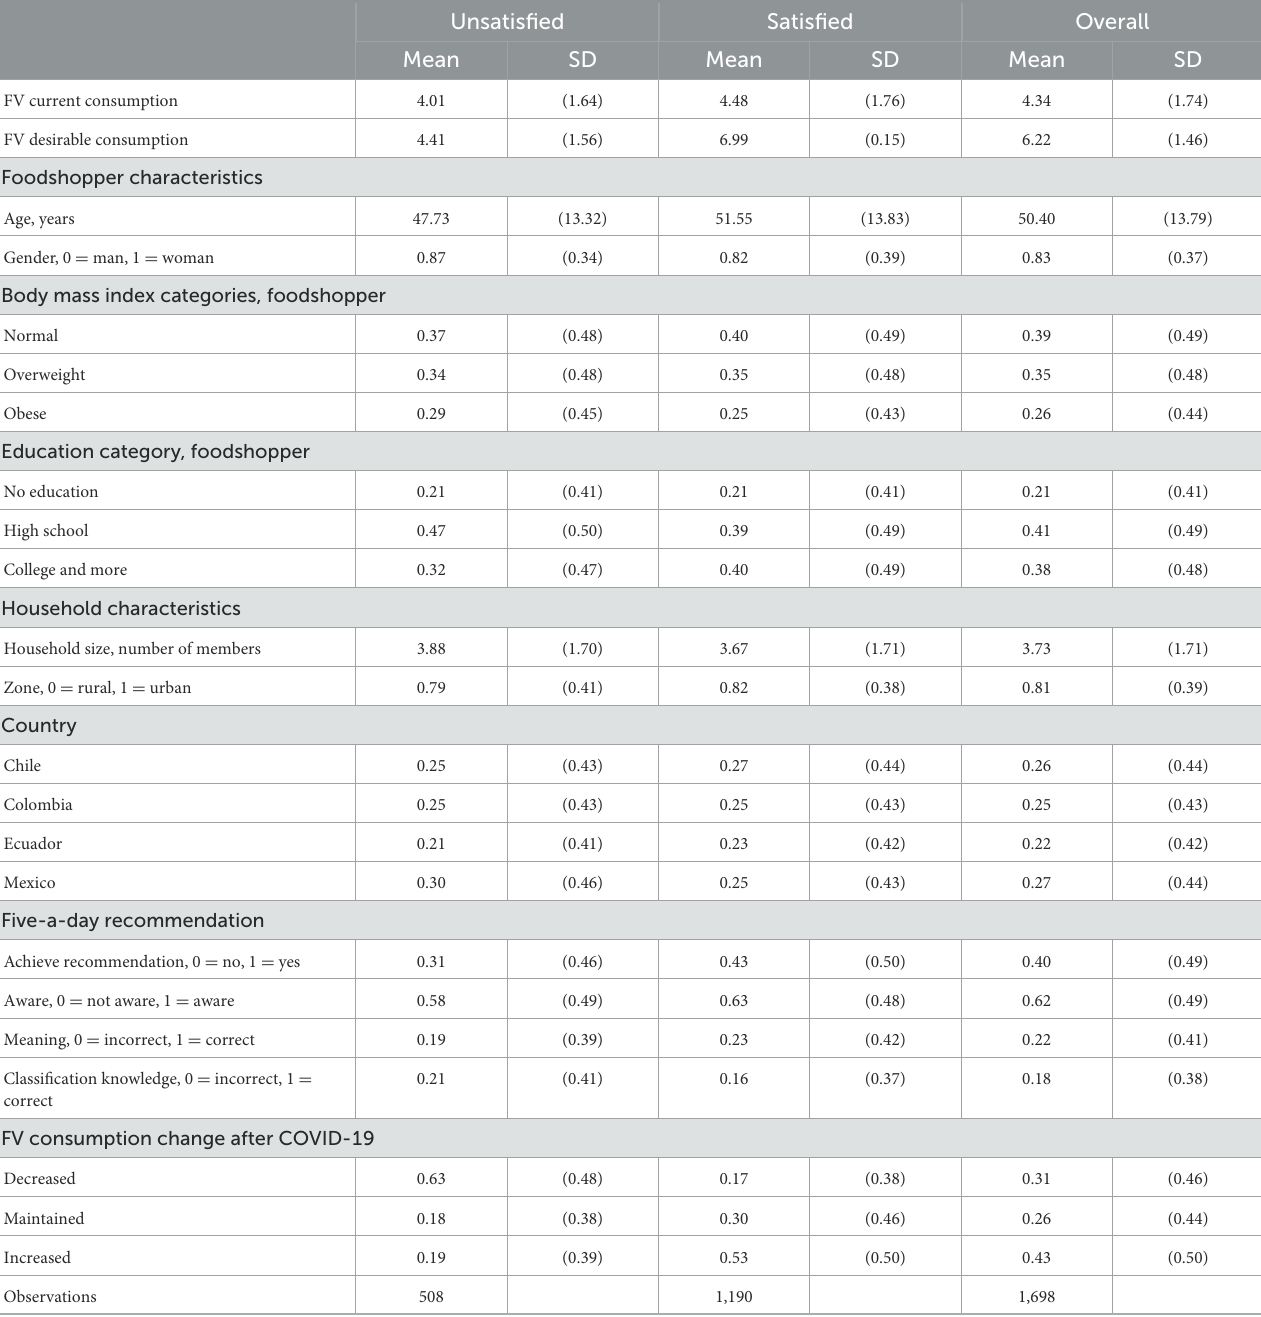
TABLE 1 Descriptive statistics by fruit and vegetable